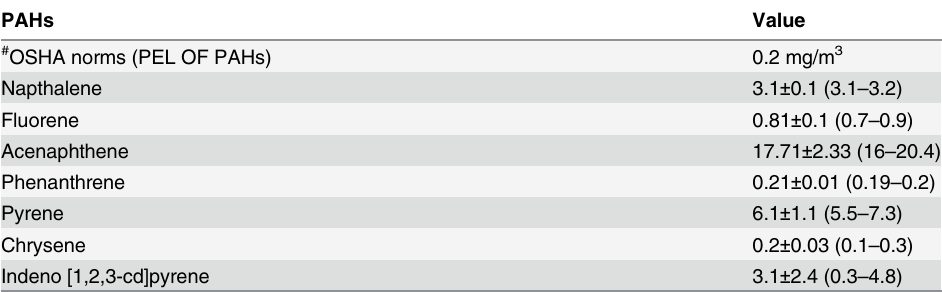
Table 4. Characterization of PAHs and their concentration (mg/m 3 ) in indoor air at kitchen. PAHs